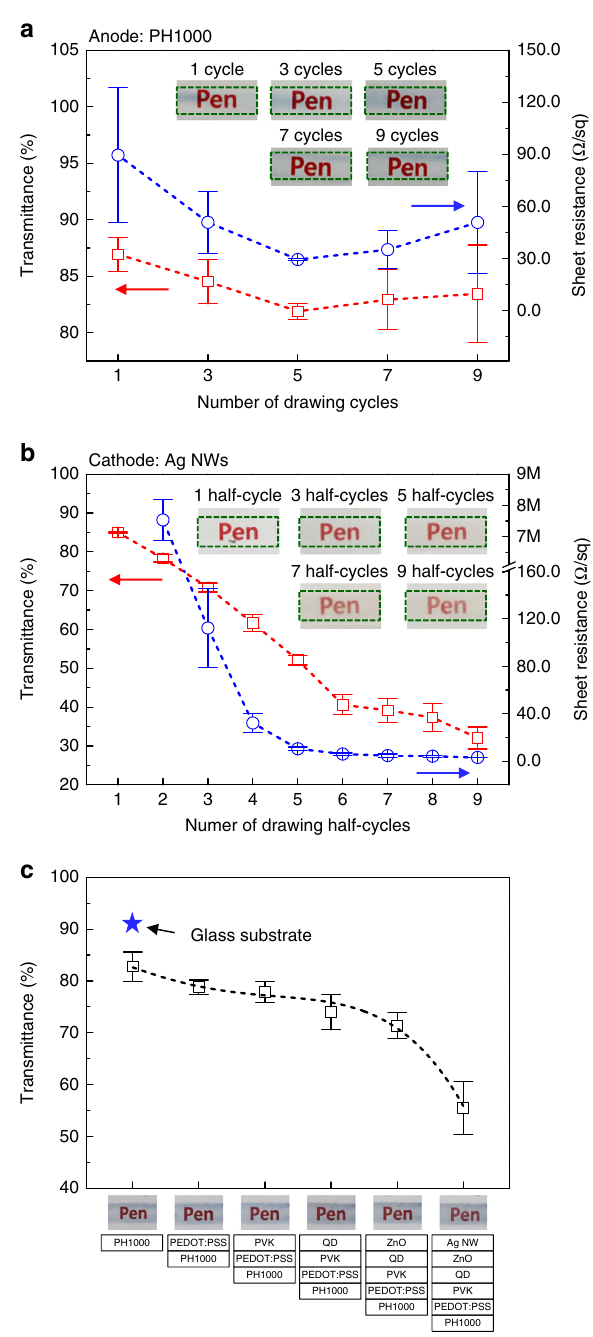
Fig. 3 Electrical and optical properties of PH1000 and Ag NWs. Sheet resistance, optical transmittance, and photo images of PH1000 ( a ) and Ag NWs ( b ) depending on the number of drawing cycles. c Transmittance when each layer (PH1000, PEDOT:PSS, PVK, QDs, ZnO NPs, and Ag NWs) is sequentially formed on a glass